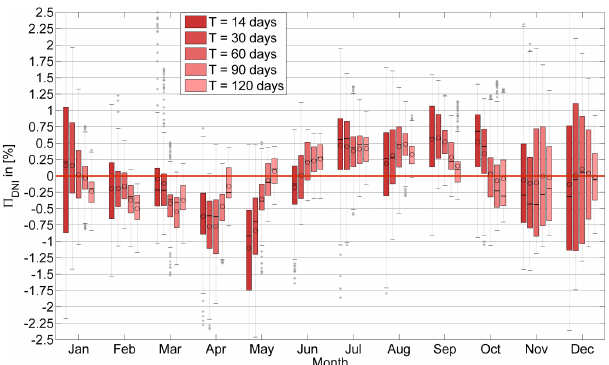
Figure 7. VigKing: distribution of (cid:53) DNI for T = 14 days, 30 days, 60 days, 90 days and 120 days sorted by calibration starting month for VigKing. (cid:53) DNI represents the deviation of calibration results from a long-term calibration in regard to